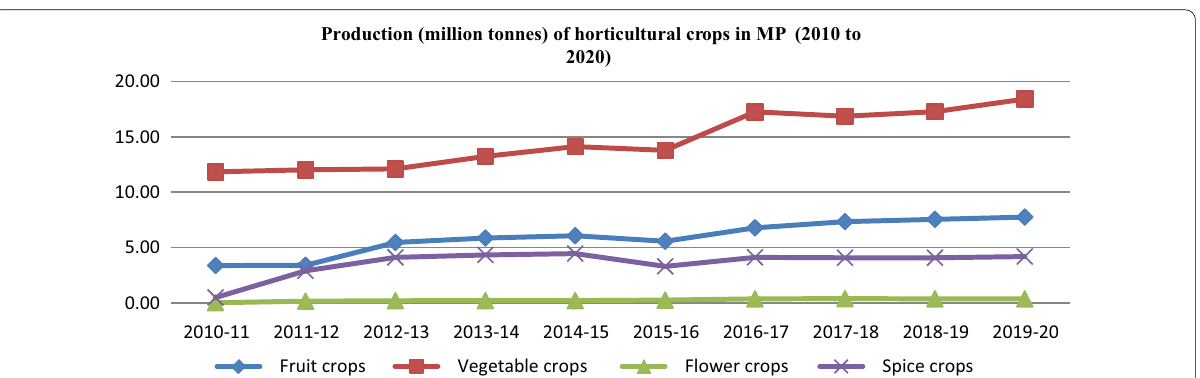
Fig. 15 Decadal growth in the production of fruit, vegetable, flower and spices in Madhya Pradesh during 2010–2020 indicates a rise in the production of all the horticultural